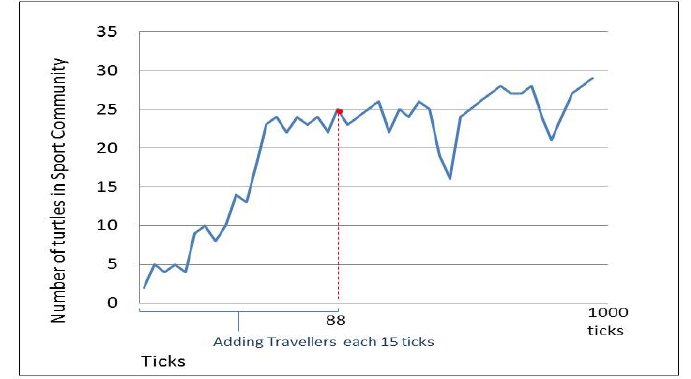
Sensors 2020 , 20 , x FOR PEER REVIEW Figure 10. Changes in sport community as an example. Figure 10. Changes in sport community as an example.